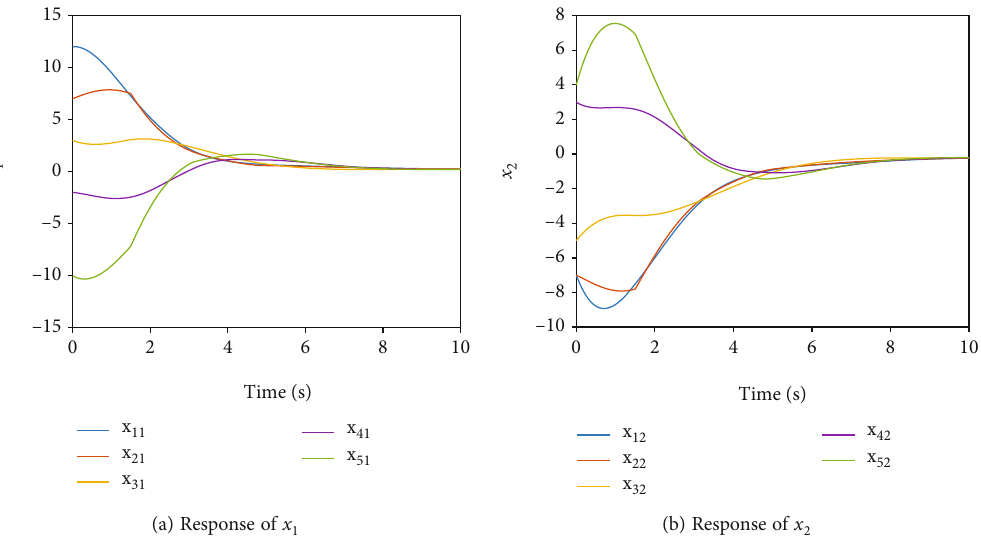
Figure 5: The response of x subject to ADT switching topologies.